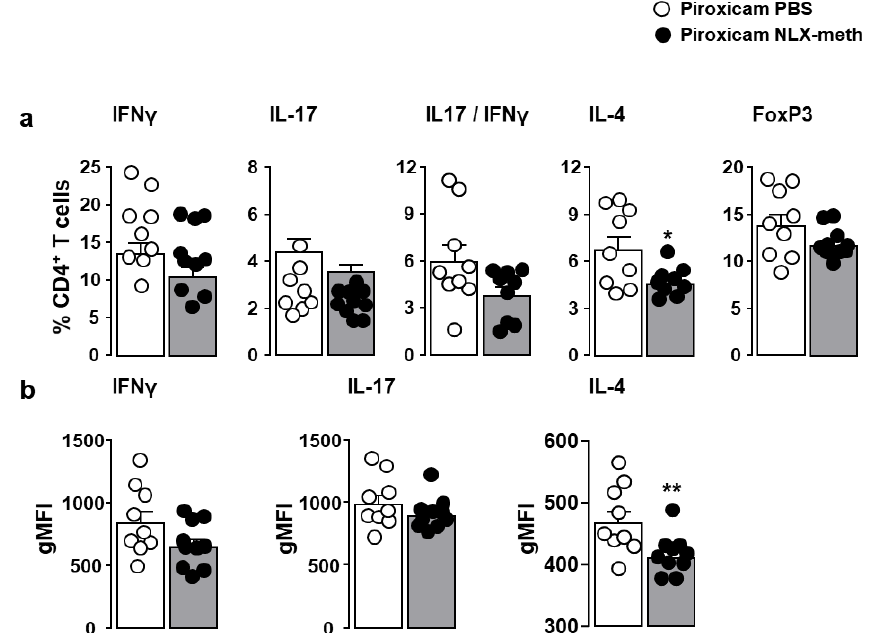
Figure 6. Effects of peripheral opioid receptor blockade on the frequency of Th1, Th17, Th2, and Treg in piroxicam-treated IL-10 -/- . IL10 -/- mice were injected with PBS (white circles) or naloxone- methiodide (NLX-meth) (black circles) two days apart for the ten days of piroxicam treatment. The frequencies of CD4 + T lymphocytes producing IFN γ (Th1), IL-17 (Th17), both IFN γ and IL-17 (Th17), or IL-4 (Th2) as well as CD4 + T lymphocytes expressing the lineage specification transcriptional factor Foxp3 (Treg) within lamina propria were analyzed by cytofluorometry ( a ). The corresponding cytokine expression levels expressed as the geometric mean of fluorescence intensity (gMFI) are depicted in panel ( b ). Each symbol represents 1 mouse ( n = 9–10/group). Statistical analysis was performed using the Mann–Whitney U test.* p < 0.05, ** p < 0.01.